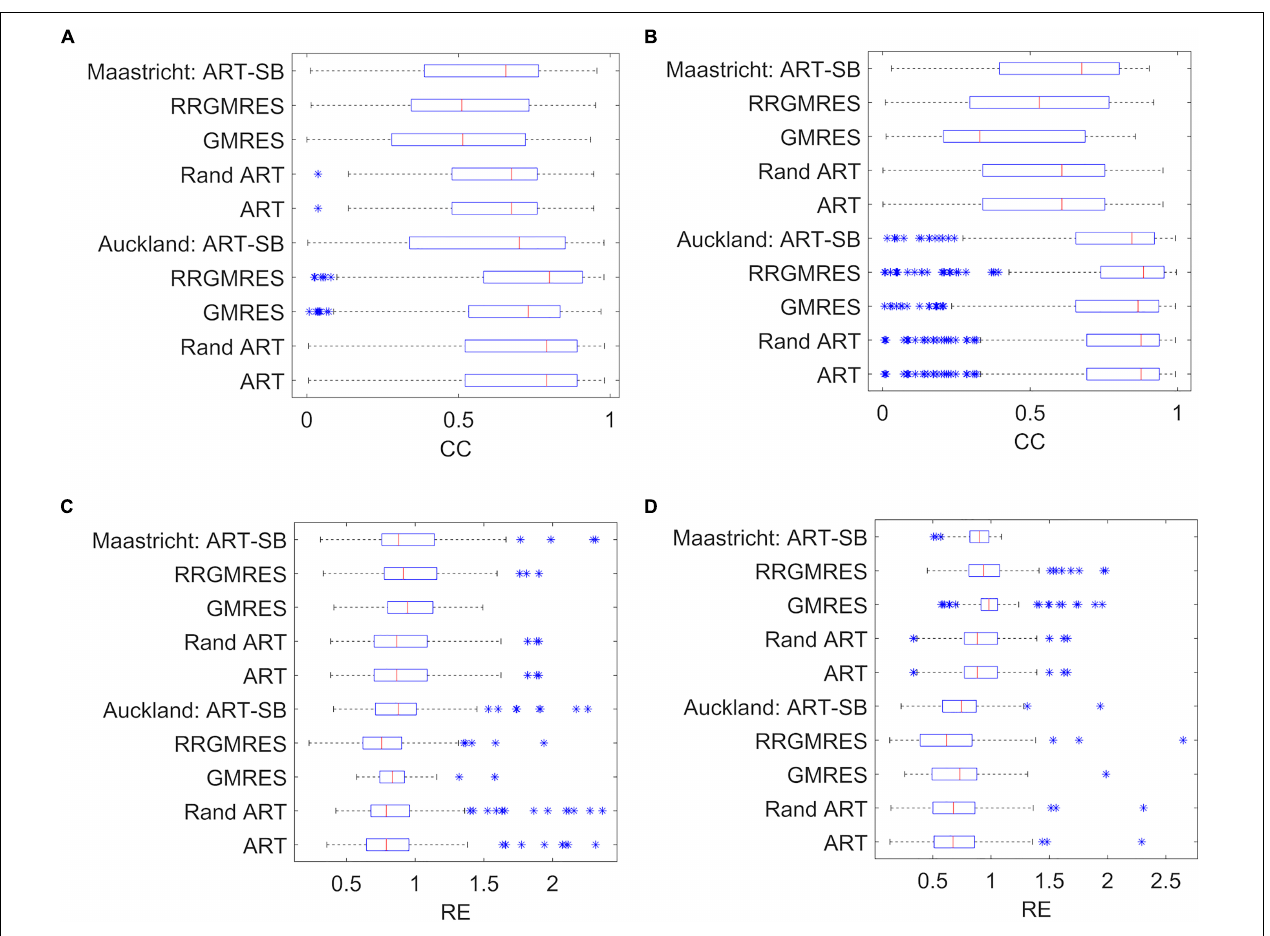
FIGURE 3 | Boxplots showing the mean, the distribution, the standard deviation (“whiskers”) and the outliers (“*”), for: (A) the CC results of the sinus rhythm; (B) the CC results of the paced rhythm; (C) the RE results of the sinus rhythm; (D) the RE results of the paced rhythm. Y -axis specify the dataset and the reconstruction method used.Similarly, for a two control subjects and four ischemia ones from the Utah dataset, the boxplots to compare the reconstructions with the respective target potentials (i.e., the provided potentials measured at the cage) were respectively shown in Figures 4 , 5